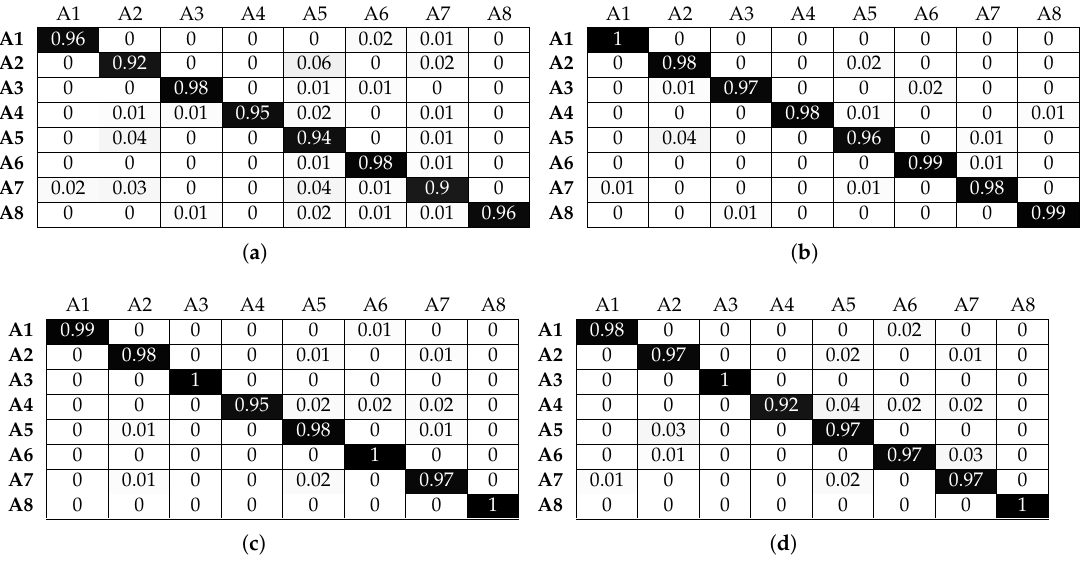
Figure 17. Normalised confusion matrices for SVM, with Wearable Feature Type 2, with beacon data. ( a ) C = 100, γ = 0.1, w = 1 s; ( b ) C = 10, γ = 0.1, w = 2 s; ( c ) C = 10, γ = 0.1, w = 3 s; ( d ) C = 10, γ = 0.1, w = 4 s.